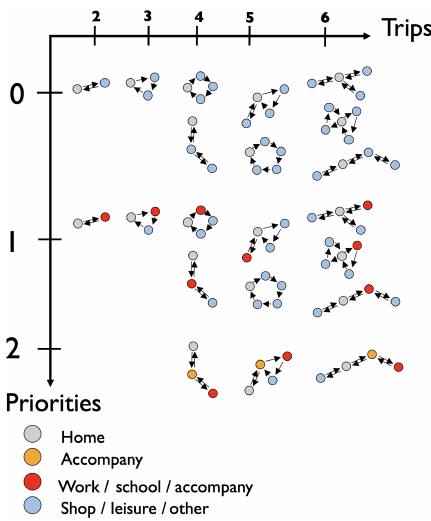
Figure 5. The transport demand module MOIRAI activities circuit based on agent priorities and daily number of trips ( p